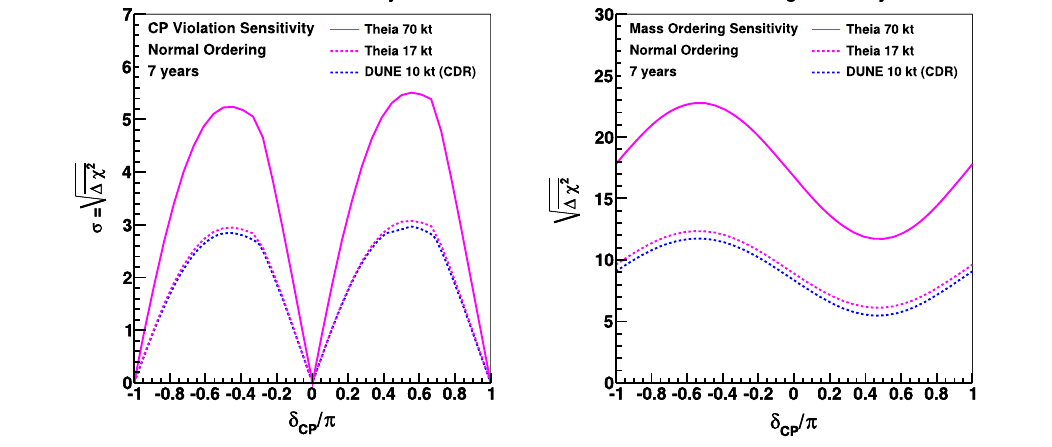
Fig. 7 Sensitivity to CP violation (i.e.: determination that δ CP (cid:4)= 0 or π ) (left) and sensitivity to determination of the neutrino mass ordering (right),asafunctionofthetruevalueof δ CP ,forthe Theia 70-ktfiducial volume detector (pink). Also shown are sensitivity curves for a 10-kt (fiducial) LArTPC (blue dashed) compared to a 17-kt (fiducial) Theia -